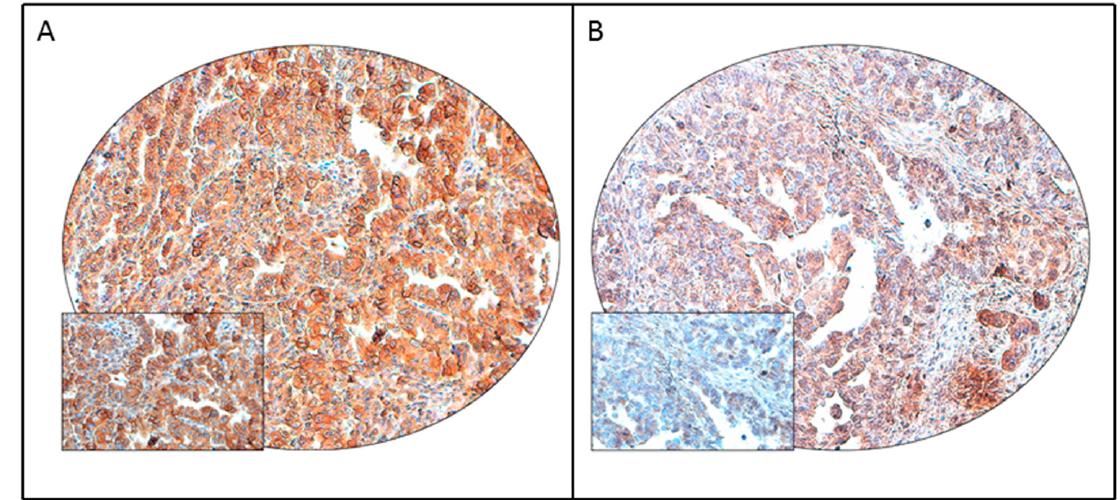
Figure 1. PD-L1 immunohistochemical staining in endometrial cancer tissue microarray (TMA). Representative examples of tumors showing ( A ) high expression and ( B ) low expression (right panel) of PD-L1. (20 × /0.70 objective on an Olympus BX 51 microscope. (Olympus America Inc, Center Valley, PA, USA) with the inset showing a 40 × 0.85 aperture magnified view of the same TMA spot).